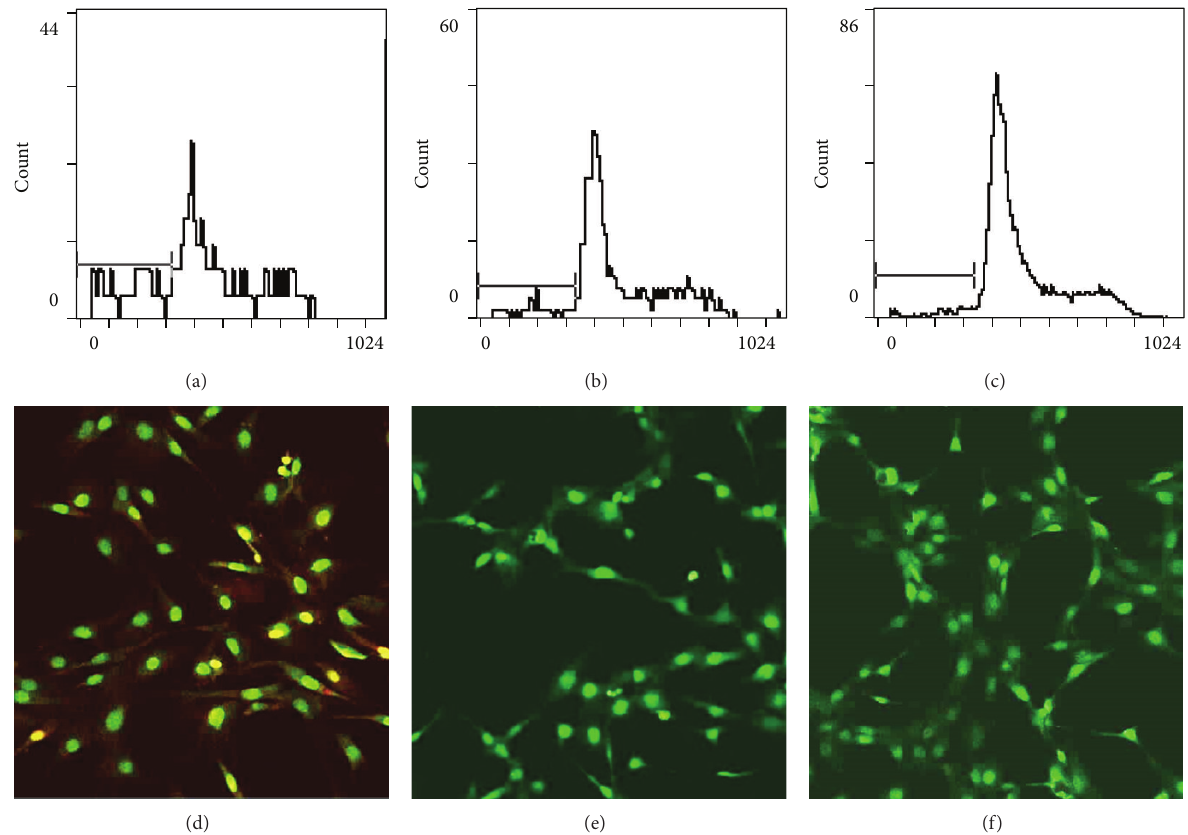
Figure 3: Cell apoptosis analysis in C20/A4 cells transfected with mutant Wisp3 Cells stably transfected with MUT 1000 T / C /pcDNA3.1(+), MUT 840 delT /pcDNA3.1(+), or empty vector; cell apoptosis was evaluated by using FAC flow cytometry (a–c) and acridine orange/ethidium bromide staining (d–f) (apoptotic cells stained with yellow, condensed, or fragmented nuclei) analysis. (a) and (d) empty vector apoptosis rate is 27.1%; (b and e) MUT 1000 T / C apoptosis rate is 9.2%; (c and f) MUT 840 delT apoptosis rate is 7.8%. Magnification is 200x.